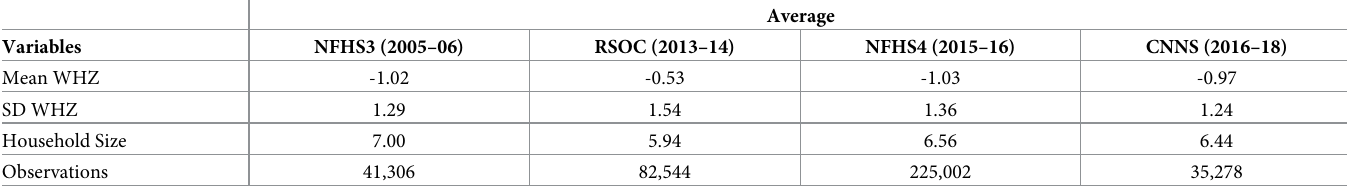
Table 2. Summary statistics of mean and SD of WHZ and household size by